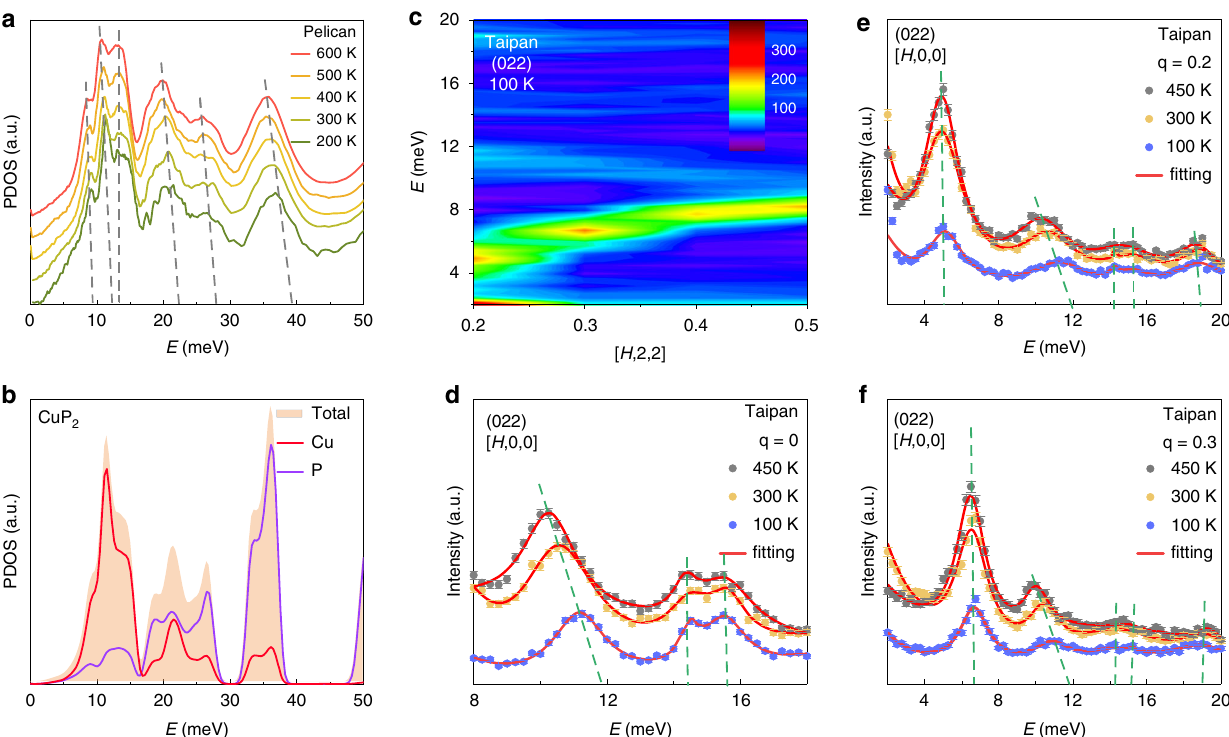
Fig. 4 Highly anharmonic optical mode at 11 meV. a The experimental PDOS, vertically shifted for clarity. b . Calculated total and partial PDOS. c . Phonon dispersion of G = (022) Brillouin zone along [ H ,0,0] at 100 K. d – f Temperature dependence of phonon spectra for constant- Q scans of G = (022) Brillouin zone along [ H ,0,0] with q = 0, 0.2, 0.3 at 100, 300 and 450 K, respectively. The green dash lines highlight the energy shift of the peaks at heating.